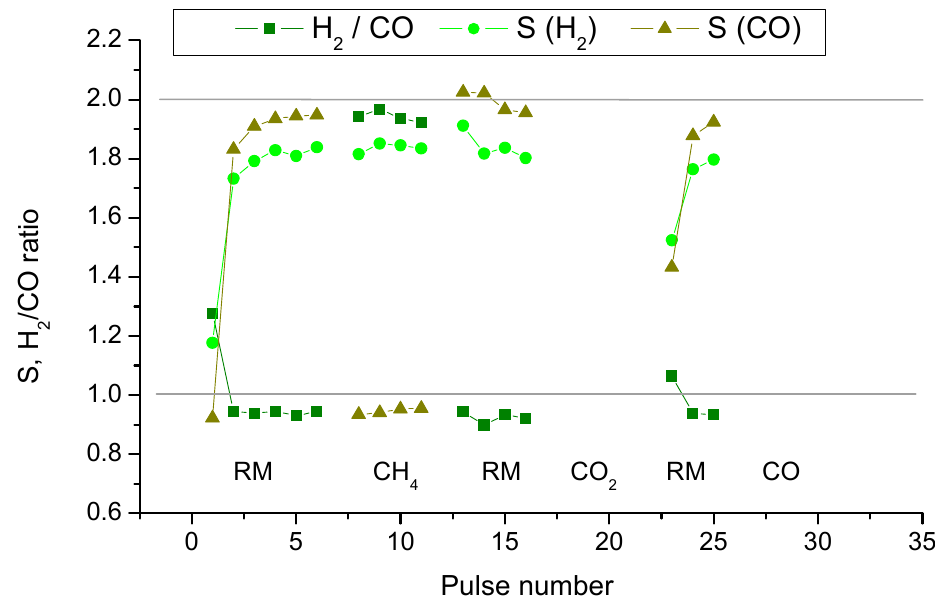
Figure 2. Product selectivities and syngas composition in series of pulses at 973 K.